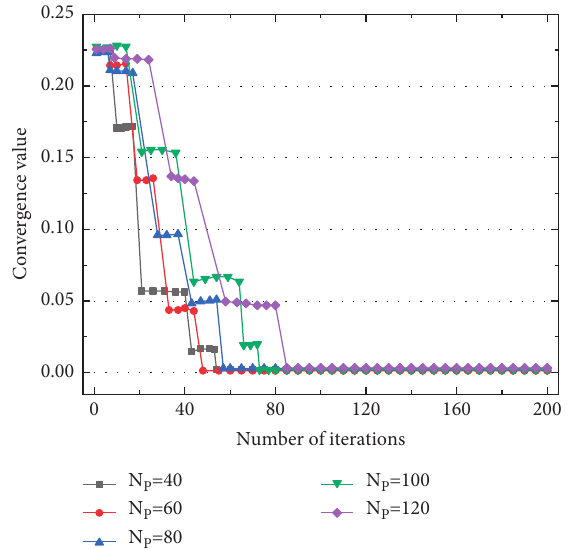
Figure 10: Iterative convergence curves of different N